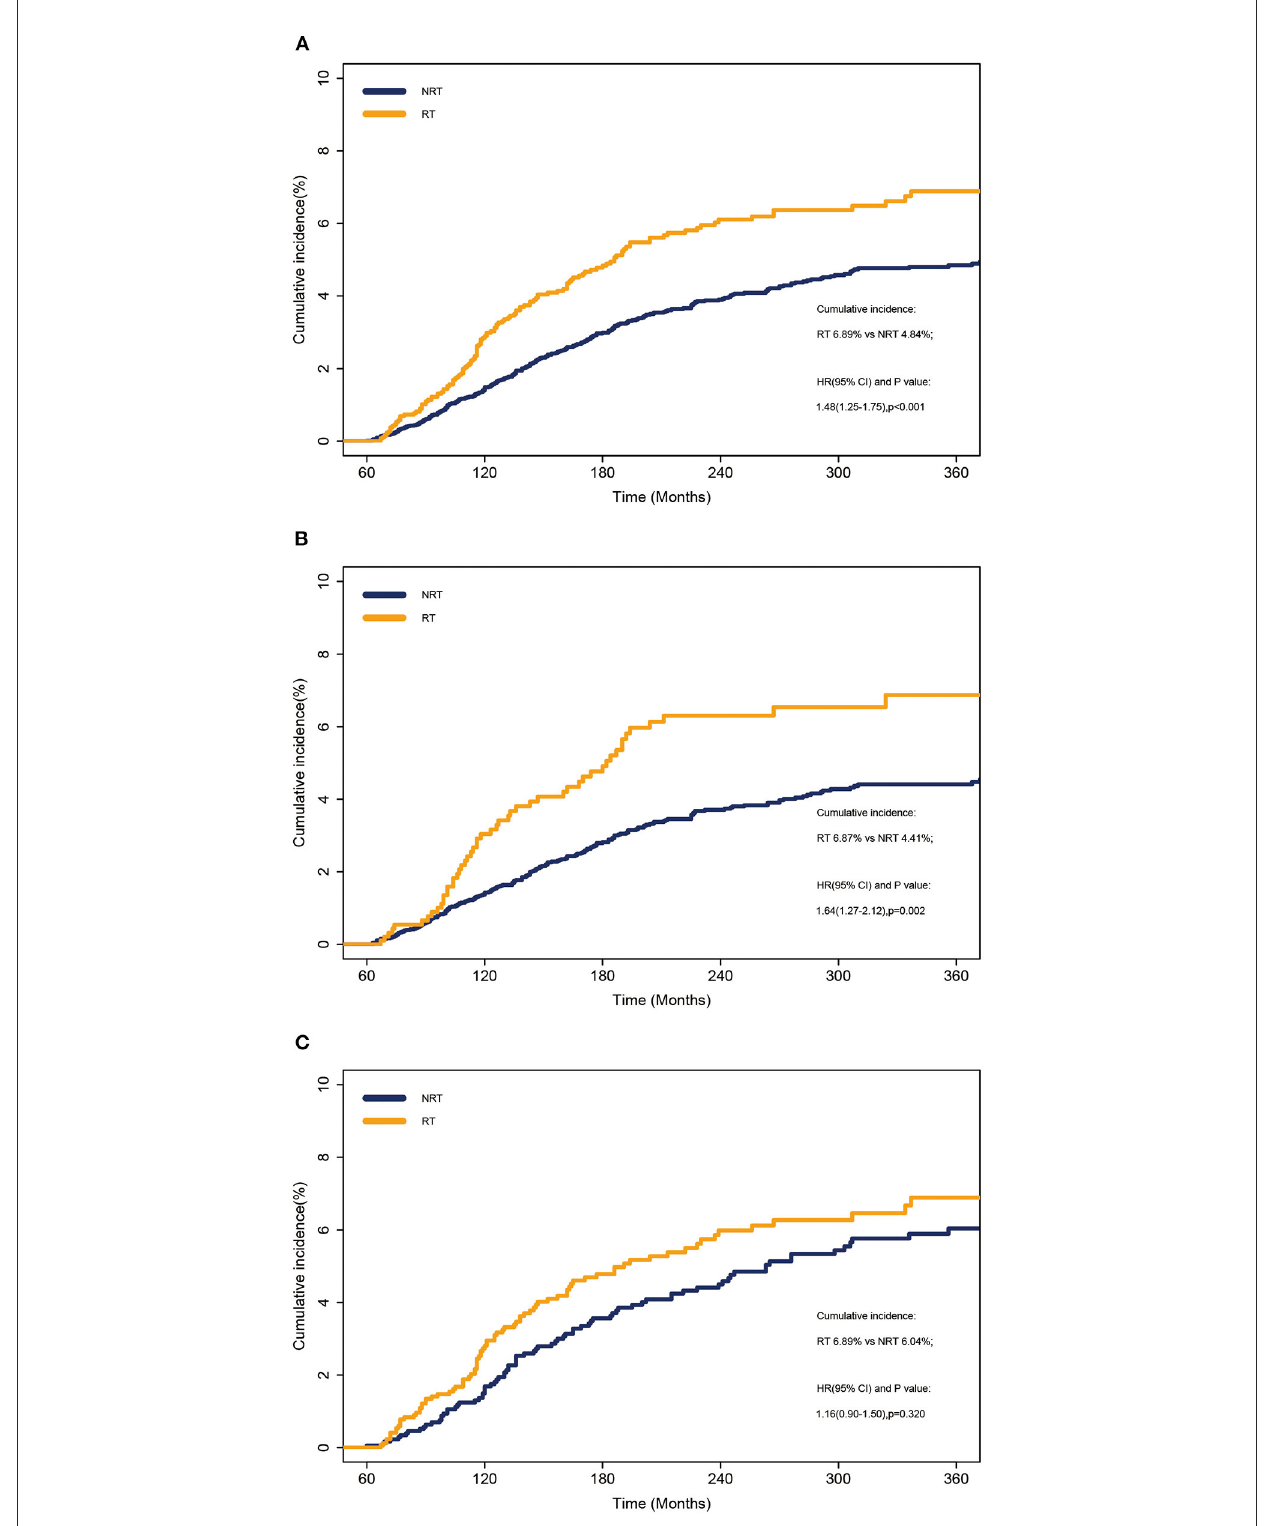
FIGURE1 Cumulative incidence of SLC between patients who received RT and those who did not received RT. (A) Overall cohort. (B) Localized disease. (C) Regional disease. NRT, no radiotherapy; RT,